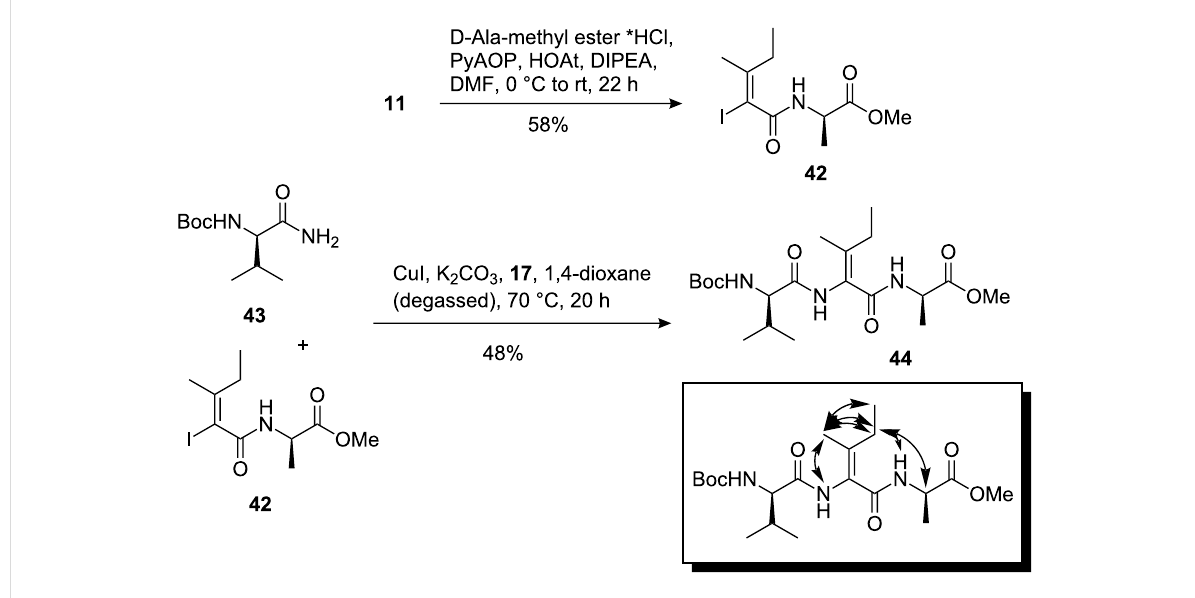
Scheme 6: C–N coupling reaction between amide 43 and vinyl iodide 42 ; formation of dehydroisoleucine containing peptide 44 . nOe assignments (tri- peptide corresponds to amino acids 11–13 in myxovalargin ( 1